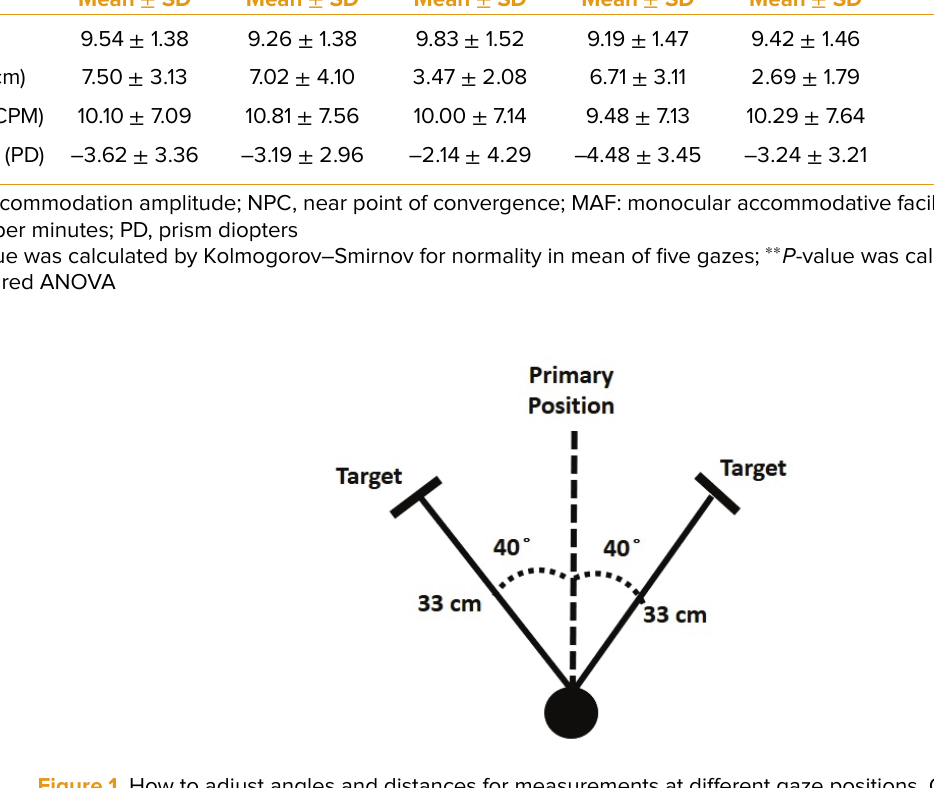
Figure 1. How to adjust angles and distances for measurements at different gaze positions. Cm;